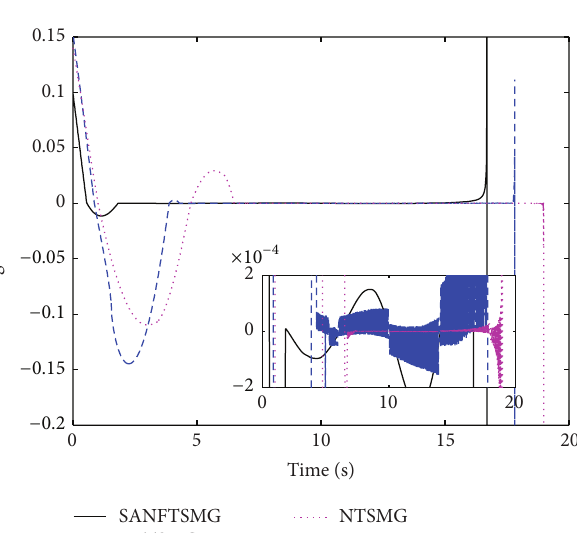
Figure 3: LOS angle (Case 1).